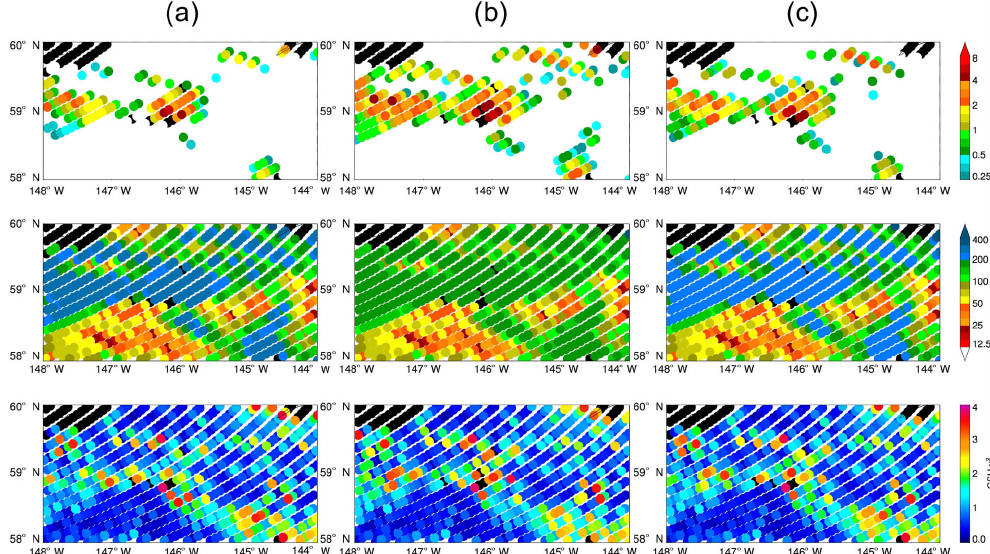
Figure A2. Sensitivity tests following Fig. 10. The panels show retrieved rain rates from the 1DVAR in cases with (a) LWP drizzle onset threshold decreased 50gm − 2 , (b) increased 50gm − 2 , and (c) using GPROF columnar rain water for the a priori